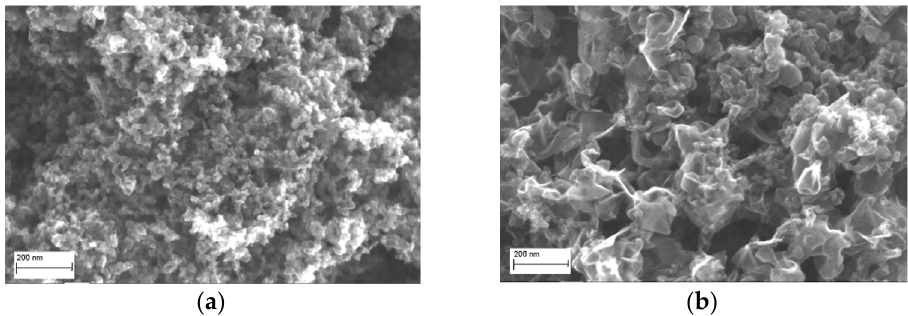
Figure 2. NDC produced by detonation of C 2 H 2 + k O 2 mixtures at oxygen content ( a ) 10% ( k = 0.11) and ( b ) 40% ( k = 0.68).